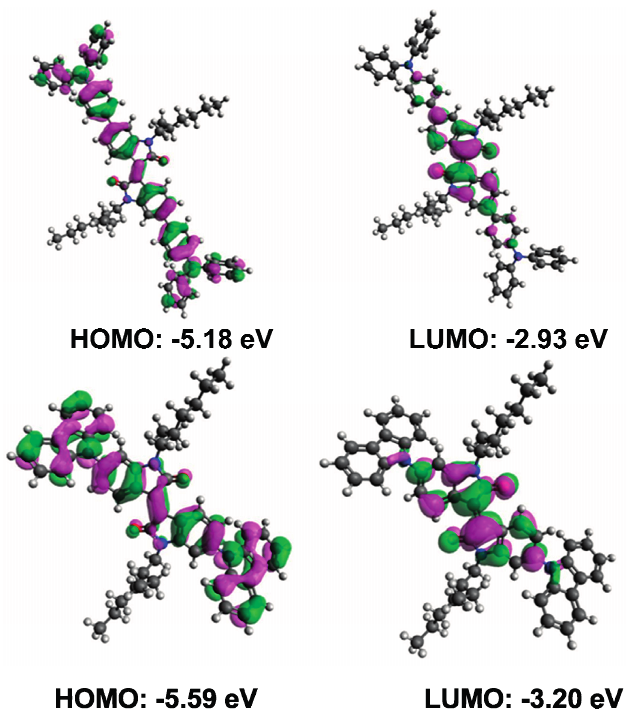
Figure 3. Orbital density distribution for the HOMOs and LUMOs of S10 (upper) and S11 (lower). DFT calculations on both the materials were performed using the Gaussian 09 software suite and the B3LYP/6-311+G(d,p)//B3LYP/6-31G(d) level of theory.